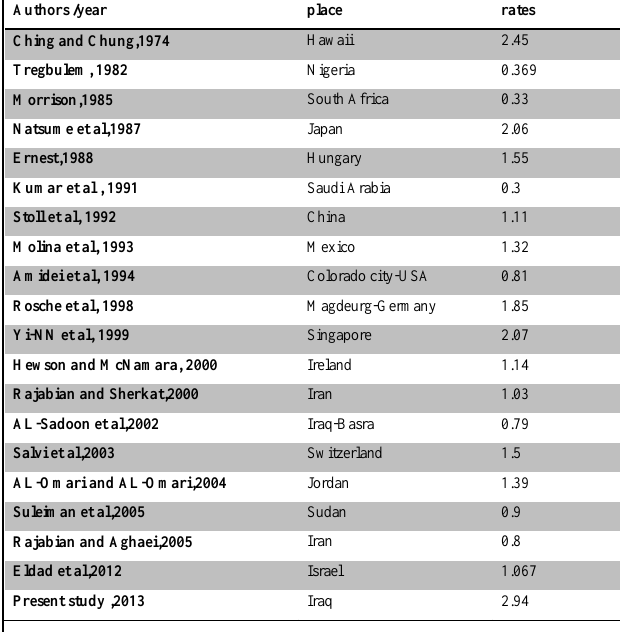
Table 1: Incidence of oro-facial clefts according to some